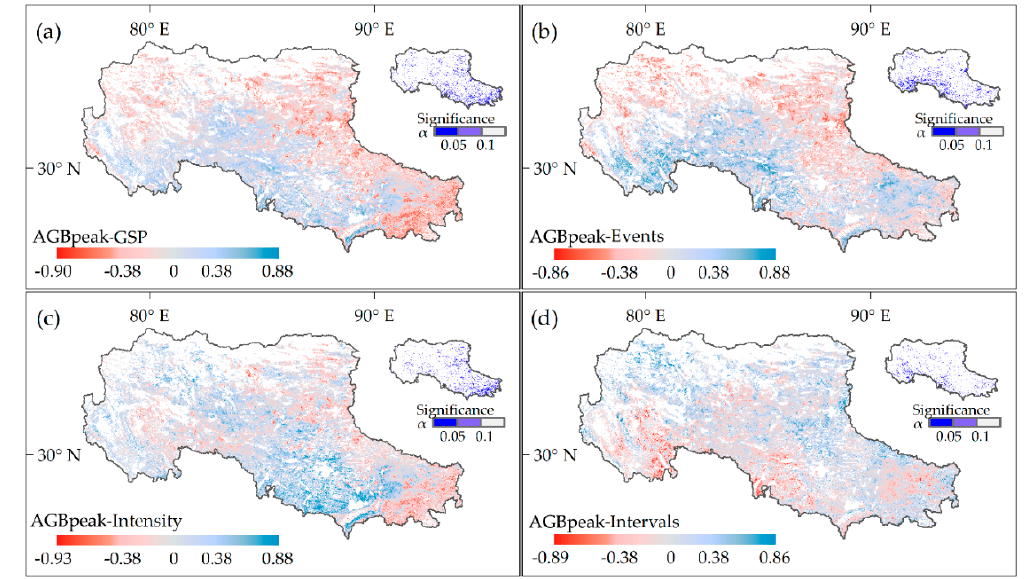
Figure 5. Spatial patterns of correlation coefficients of peak aboveground biomass (AGB peak ) with ( a ) growing season precipitation (GSP), ( b ) number of precipitation events, ( c ) mean intensity of precipitation events, and ( d ) time interval between precipitation events in alpine grasslands on the northern Tibetan Plateau.